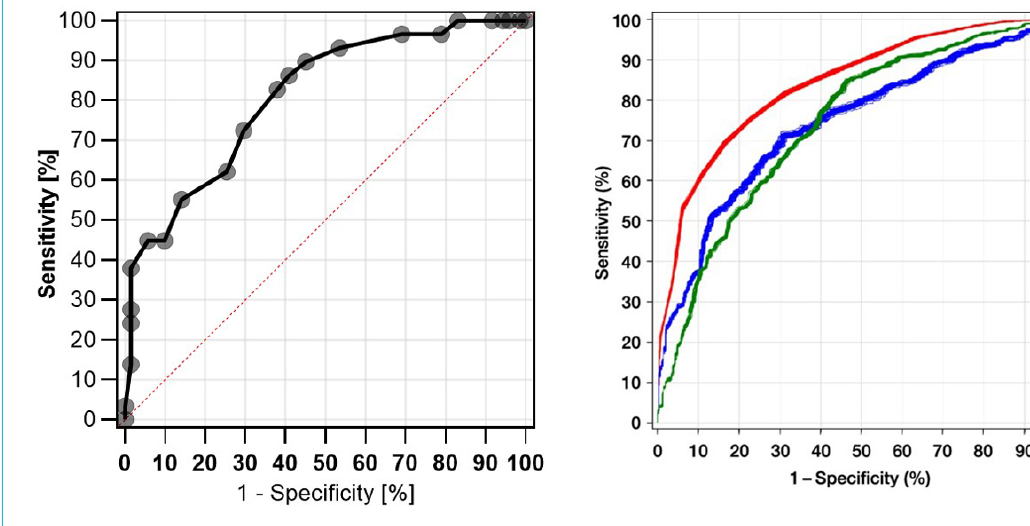
Figure 1: The receiver operating characteristic curves of the Target Temperature Management (TTM) risk score in the Bern cardiac arrest population admitted to the Inselspital, University Hospital Bern intensive care unit (left). On the right, the ROC curves for a poor outcome at 6 months for other predication scores: the TTM [7] (red), OHCA [11] (blue) and CAHP [12] (green) risk scores. The area under the curve (AUC) of the TTM score in the Bern population (0.81) is not significantly different from the AUC of the original TTM population [7] (AUC 0.842). The AUC for the OHCA score is 0.746, and for the CAHP score, it is 0.746. The figure on the right is from Martinell et al, Crit Care 2017;21:96